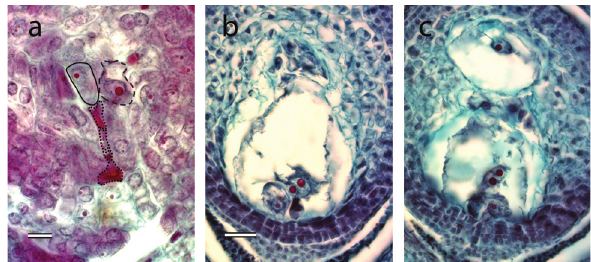
Figure 3 - Female gametophyte development in Paspalum modestum . (a) Photomicrograph of a section of an ovule at the end of meiosis showing a functional megaspore together with three aborted megaspores and a vacu- olated initial of apospory cell. (b) Mature Polygonum -type gametophyte depictinganegg-cell,abinucleatecentralcellandamassofantipodalcells at the chalazal pole. (c) Mature meiotic gametophyte as shown in b, plus a nucellar gametophyte towards the chalaza. All photomicrographs are dis- posed with the micropyle towards the base of the figure. The scale bar in a represents 20 (cid:3) m, and in b-c represents 50 (cid:3) m.